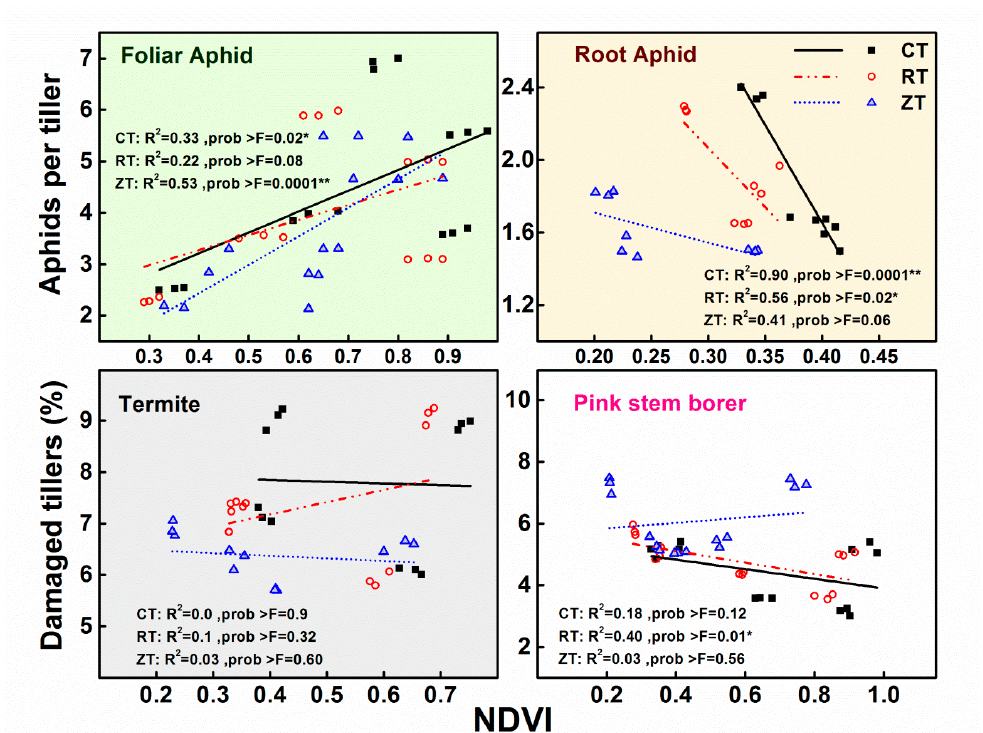
Figure 8. Correlation between standardized NDVI (day − 1 ) and aphid abundance (aphids/tiller) or damage (%) in wheat grown under 3 tillage practices during 2016–2017 and 2017–2018 (pooled). (‘*’— p < 0.05; ‘**’— p < 0.01).